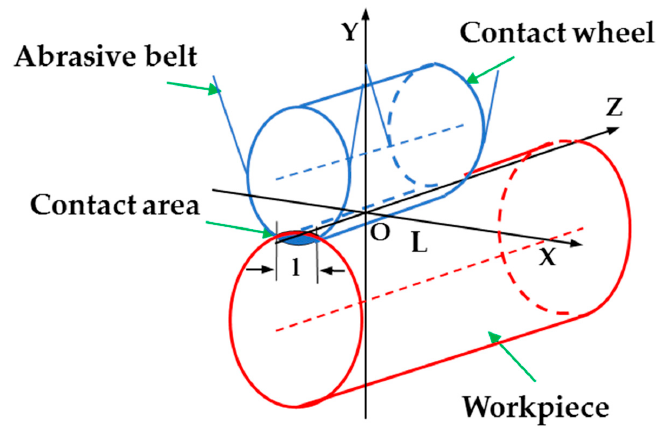
Figure 2. Contact between two cylindrical surfaces with parallel axes.